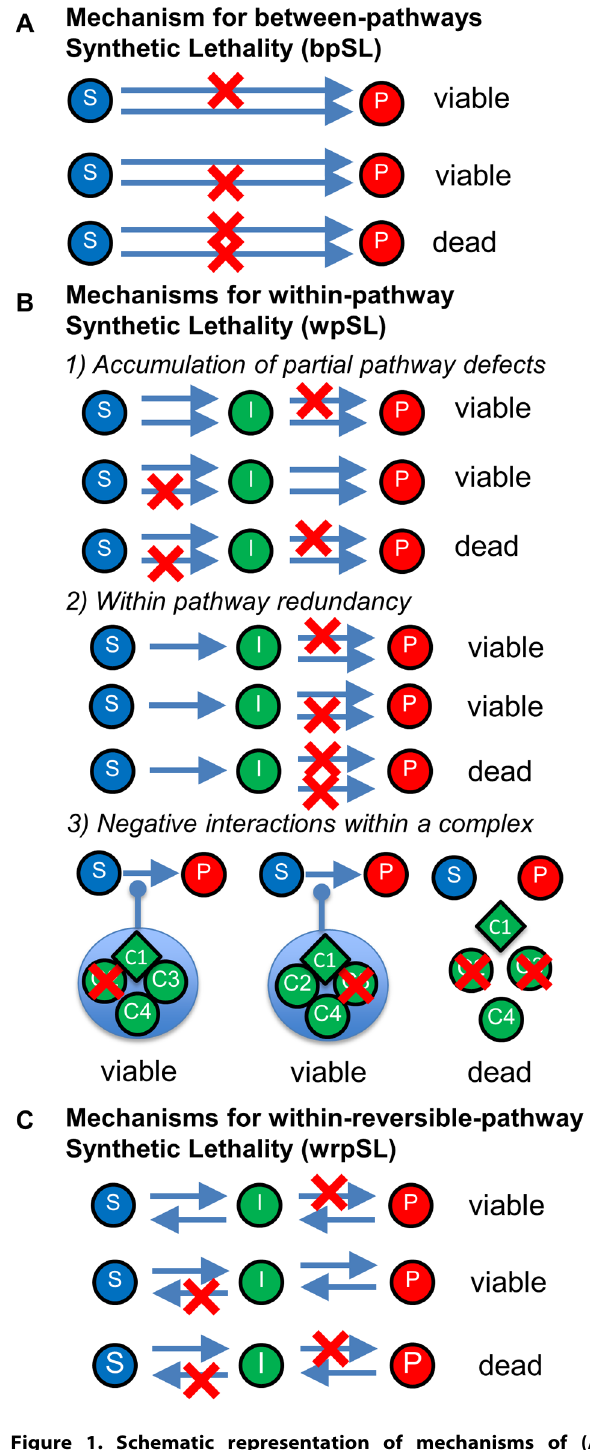
Figure 1. Schematic representation of mechanisms of (A) between-pathways Synthetic Lethality, (B) within-pathway Synthetic Lethality, and (C) within-reversible-pathway Syn- thetic Lethality. S: substrate, I: intermediate, P: product, C1–4: components of a protein complex. Red crosses define single mutations. For details see